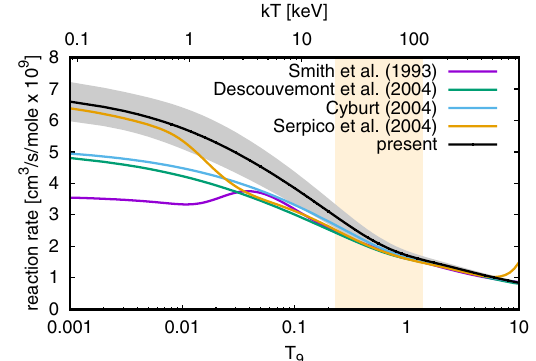
Figure 3. Comparison of the reaction rates for the 7 Be(n,p) 7 Li reaction of the present work with some of the commonly adopted rates ([8–11]). The uncertainty associated with the presently de- termined rate is shown by the corresponding grey band. The tem- perature range of interest for BBN is indicated by the vertical